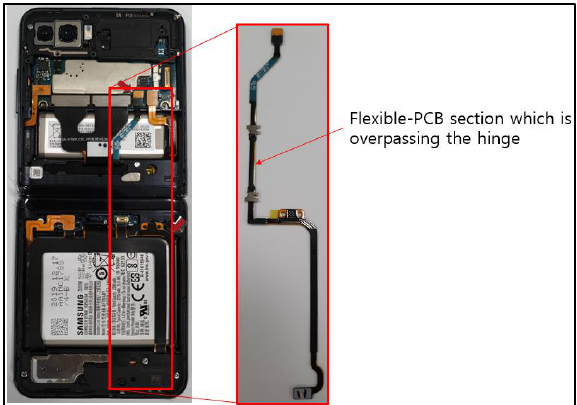
Figure 14. Proposed flexible PCB structure applied to mass-production of Galaxy Z-flip.